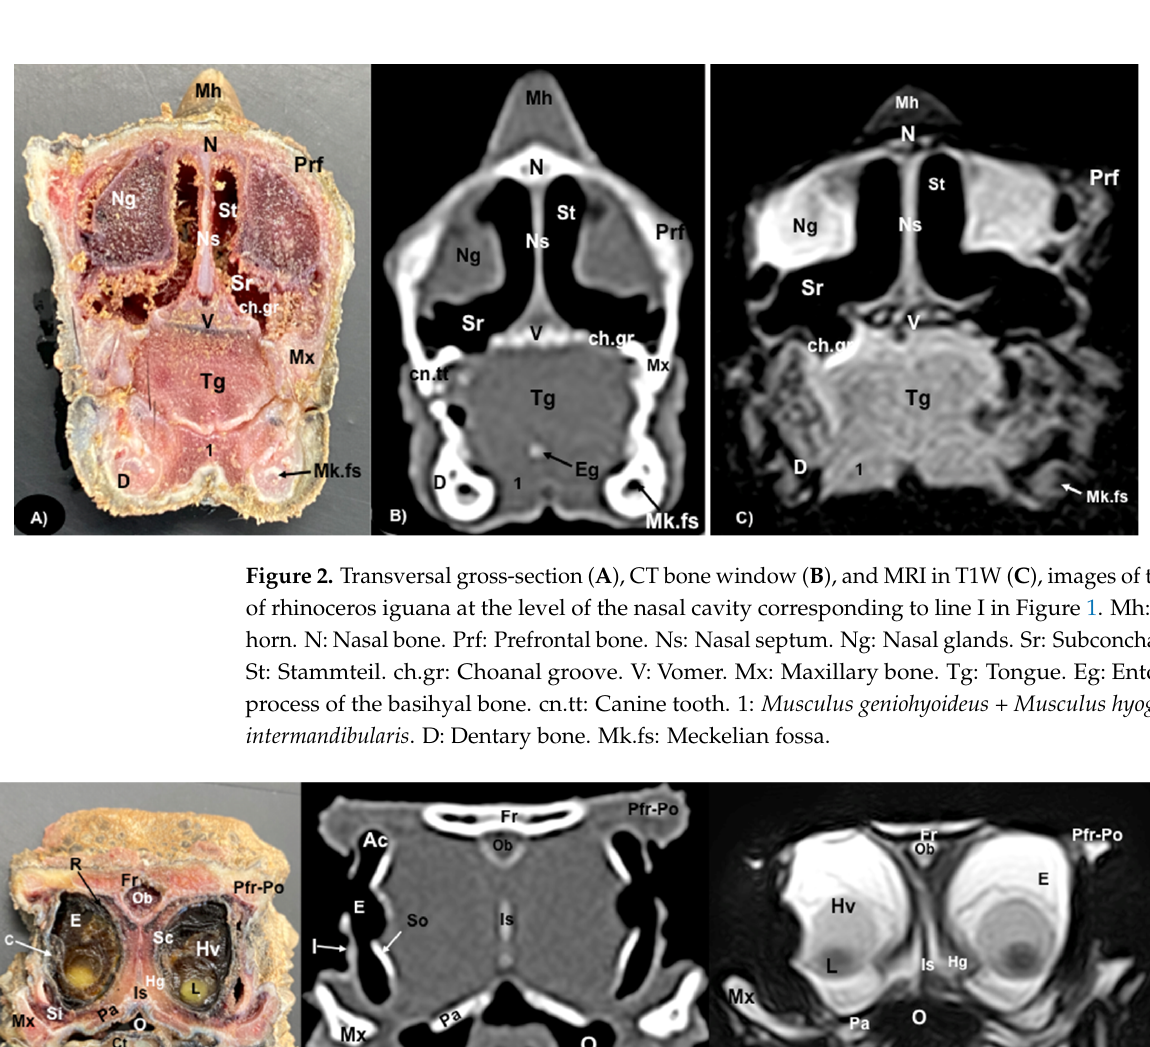
Figure 1. Sagittal CT bone window image of the head of rhinoceros iguana that approximately rep ‐ resenting the level of the slices of this study. Segments I–V correspond to Figures 2–6.